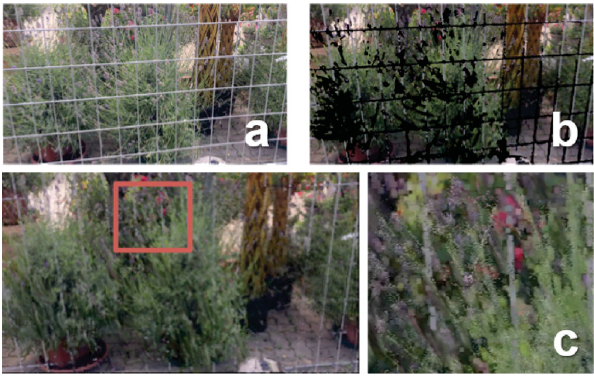
Fig. 15 Failure in DT fence segmentation: (a) input frame, (b) fence mask superimposed on camera data, and (c) result of our